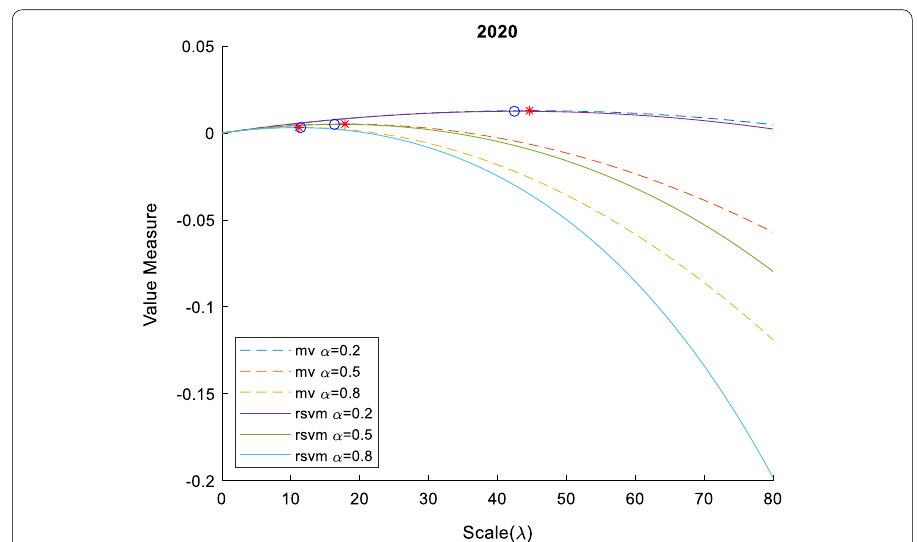
Fig. 7 Value measure of RSVM and MV with various risk aversion α and scale (cid:31) In 2020. This figure shows the relation between value measure (mean–variance model with dash line and risk‑sensitive value measure with line) and scale with different investors (risk‑averter α = 0.8 , risk‑neutral α = 0.5 , and risk‑seeker α = 0.2 ) in 2020. The red star and blue circle are optimal scale of mean–variance model and risk‑sensitive value measure, respectively